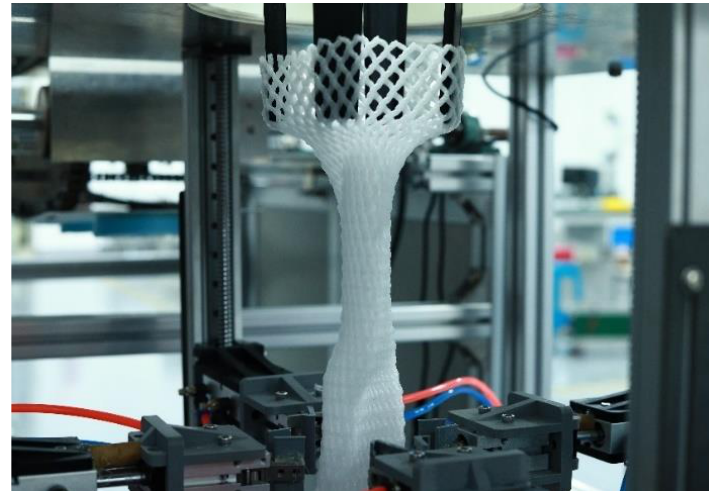
Figure 24. Working screen of the nesting device. Table 4. Apple foam net packaging machine experimental results.